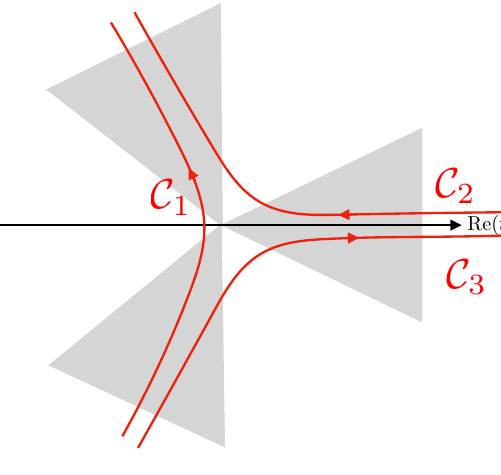
Figure 7: Choices of contours for the Airy integral. The allowed regions shown in grey with ranges − defined θ = arg t . A ‘good’ contour approaches the point at infinity along one of the allowed directions and connects two good